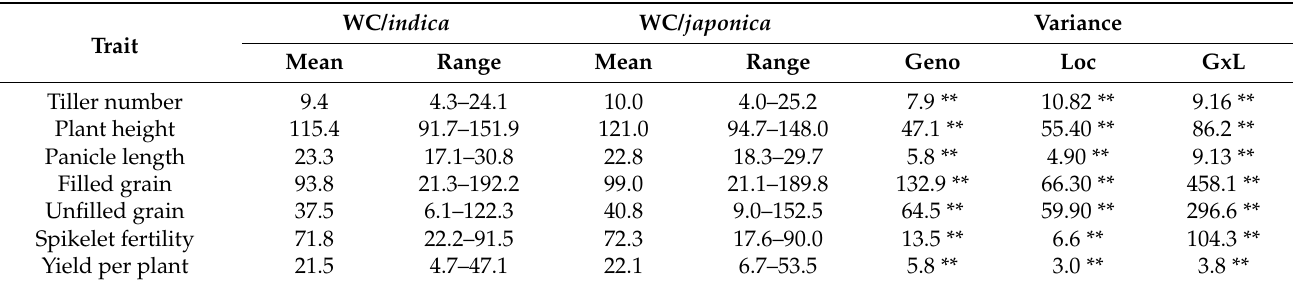
Table 6. Combined ANOVA for different agro-morphological traits based on evaluation of 164 hybrids along with 4 checks in augmented block design across 3 environments .